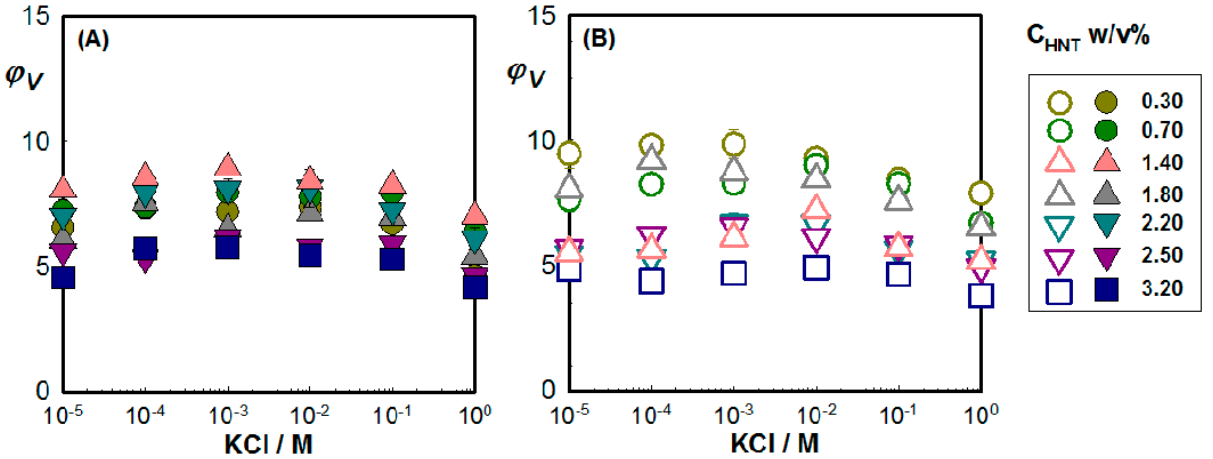
ϕ ϕ of HNTm/PHAD-Hgs ( A ) and HNTm/PHAD-Cgs ( B ) as a function of HNTm/PHAD-Hgs ( A ) and HNTm/PHAD-Cgs ( B ) as a function